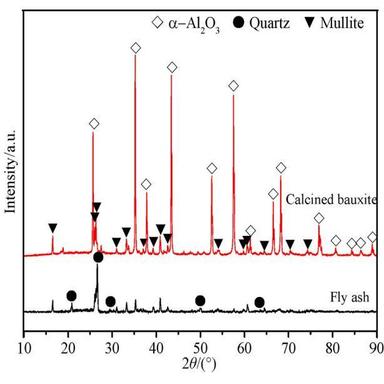
XRD patterns of raw materials.